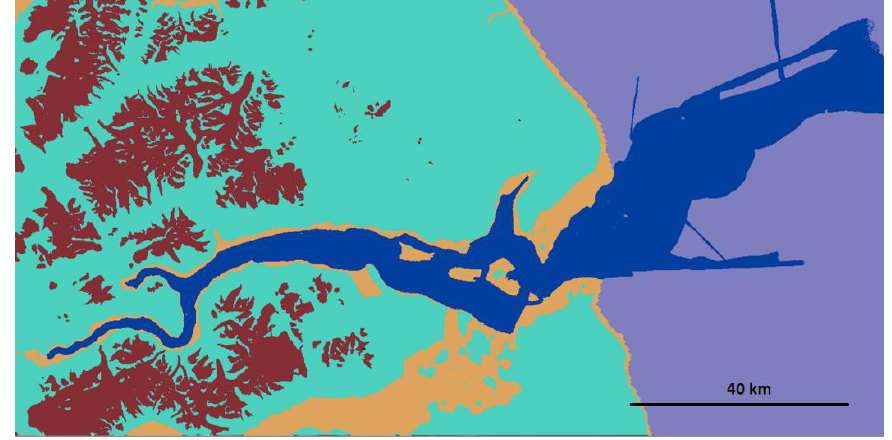
Figure 7. Splat map defining five territories: MSM66 bathymetry data (blue), IBCAO data (purple), transition (orange), the terrestrial elevation model (turquois), and glaciers (ruby).